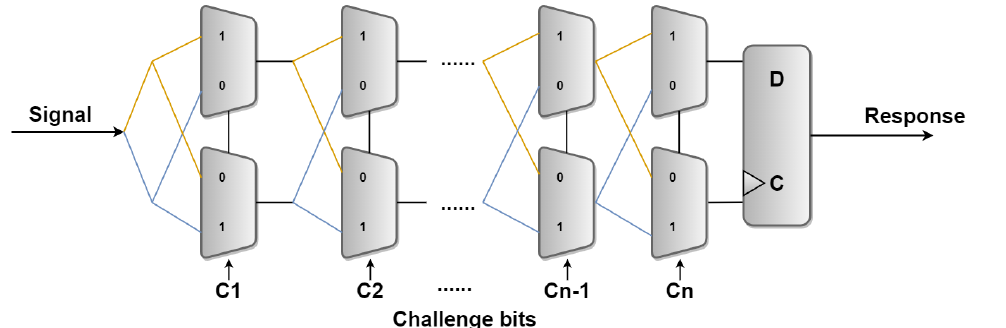
Figure 1. An arbiter PUF with n bits of